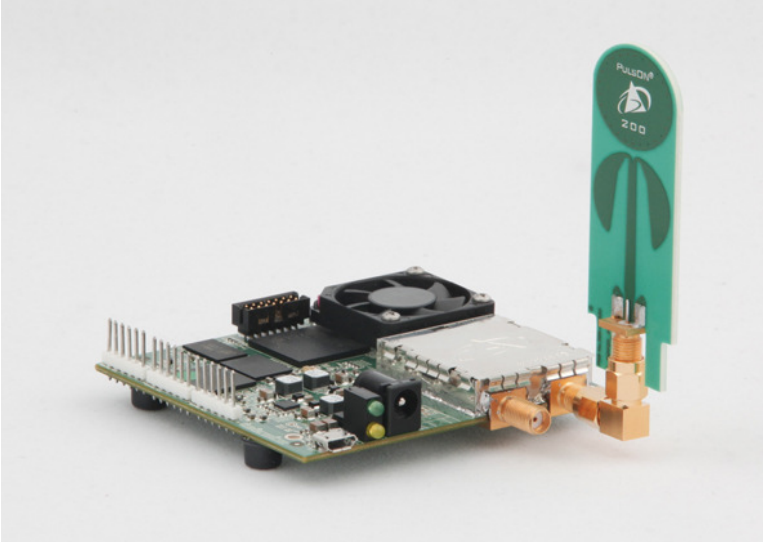
Figure 1. A P410 RCM used to obtain experimental